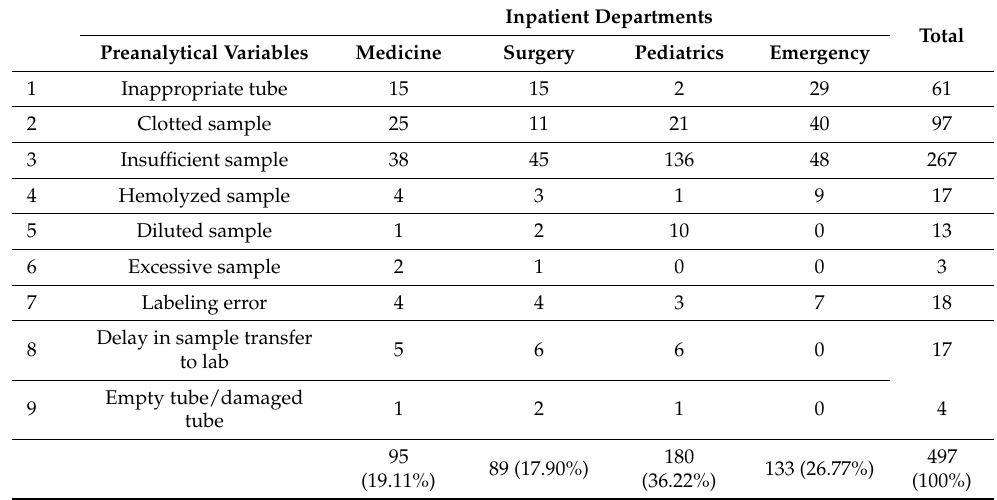
Table 3. Frequency distribution of preanalytical variables among the various inpatient